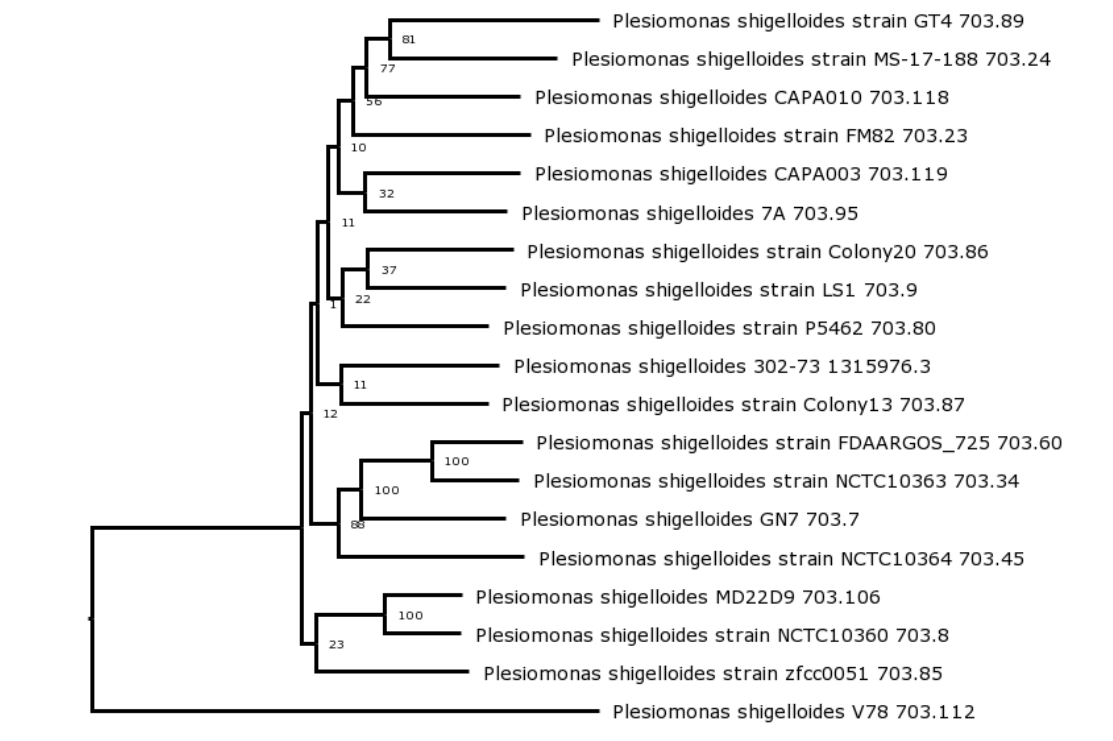
Figure 2. The codon tree based on 931 single-copy genes found in the genomes of strain V-78 and its close relatives within the species P. shigelloides, built using the BV-BRC server (https://www.bv-brc.org/app/PhylogeneticTree (accessed on 24 March 2023)). Table 1. P. shigelloides strains compared in this study.